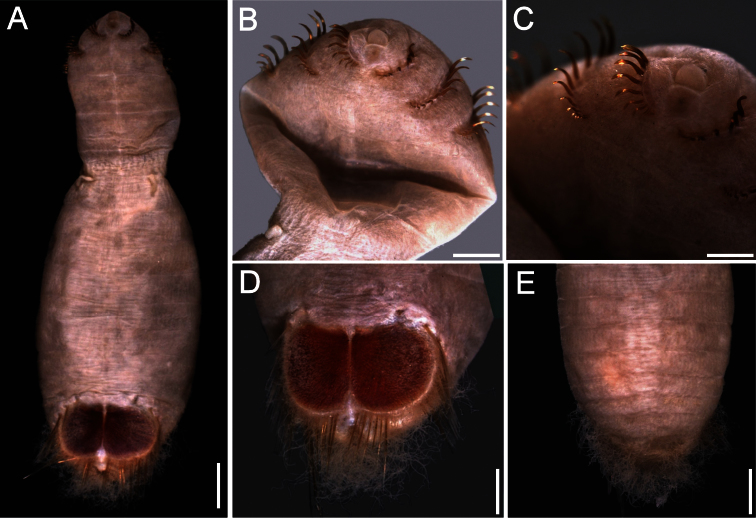
Petersenaspis capillata (Nonato, 1966) comb. n., syntypes (MCEM 1333) A Complete, ventral view B Another syntype, anterior end, ventral view C Same, enlargement to show subdistally expanded chaetae D Same, ventro-caudal shield, frontal view E Another syntype, posterior region, dorsal view. Bars: A 1 mm B, D 0.6 mm C 0.4 mm E 0.9 mm.